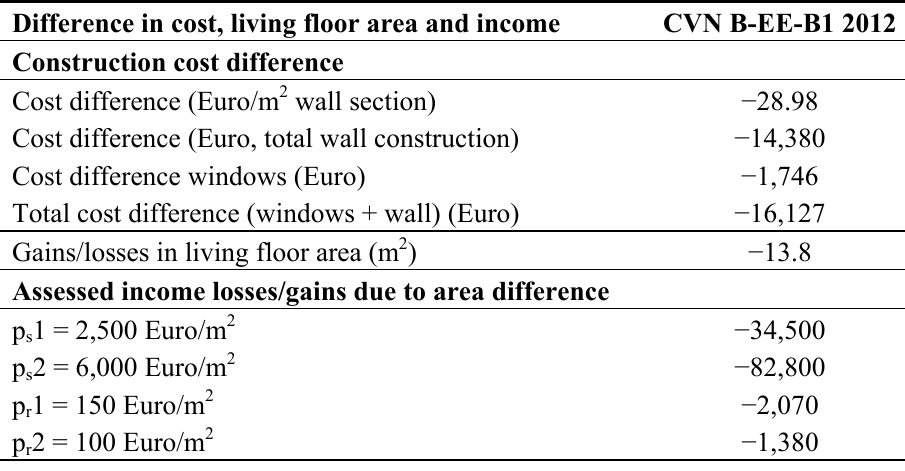
Table 8. Cost difference and assessed living area lost between conventional and energy-efficient building constructed in 2013, brick